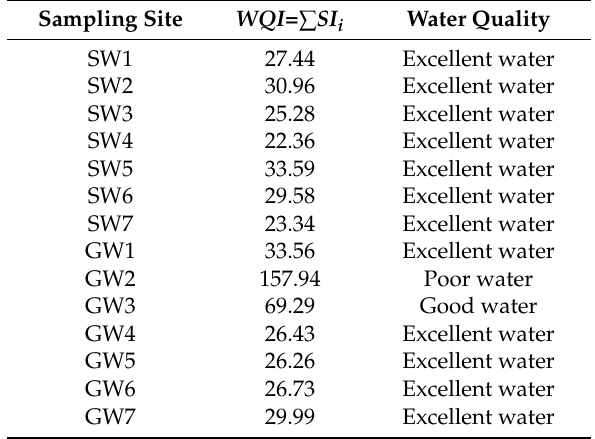
Table 5. The details of the water quality status of each water